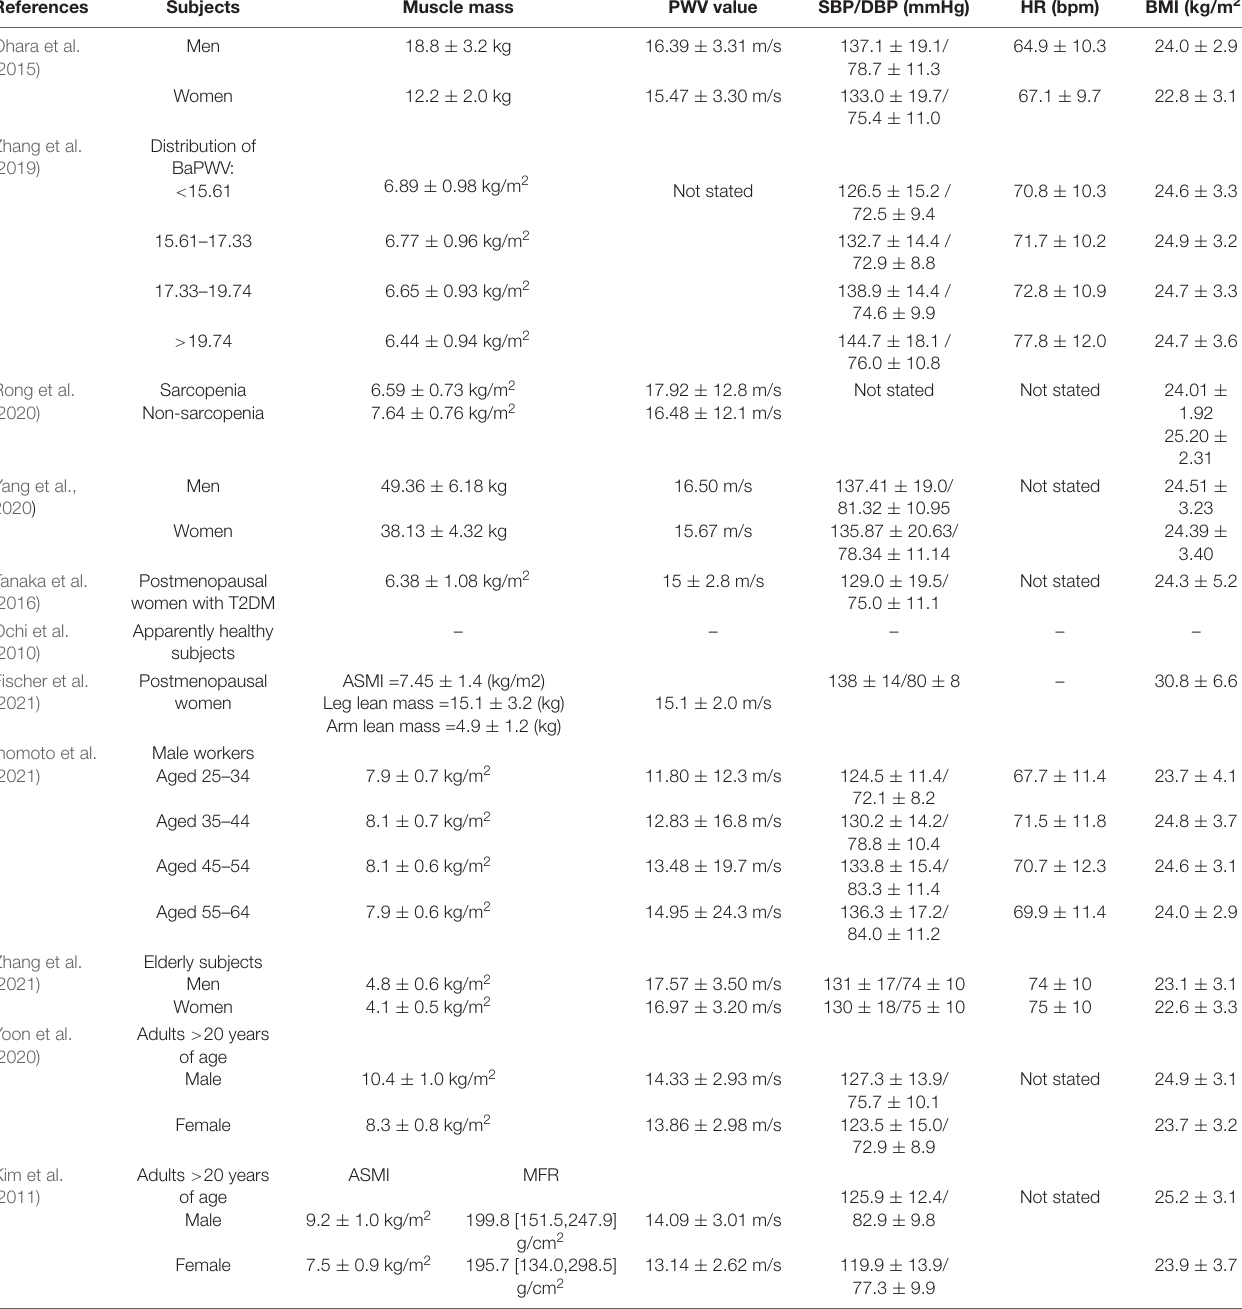
TABLE 5 | Values of related parameters in each study (muscle